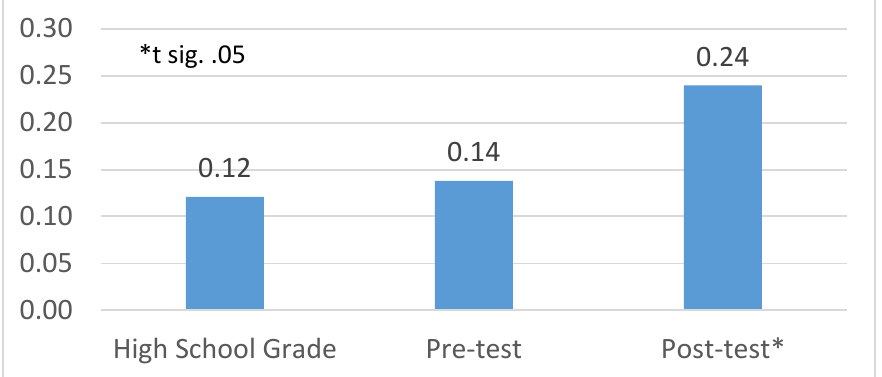
FIGURE 10. BETAS FOR REGRESSION OF OVERALL GPA FOR 1010 B AND C